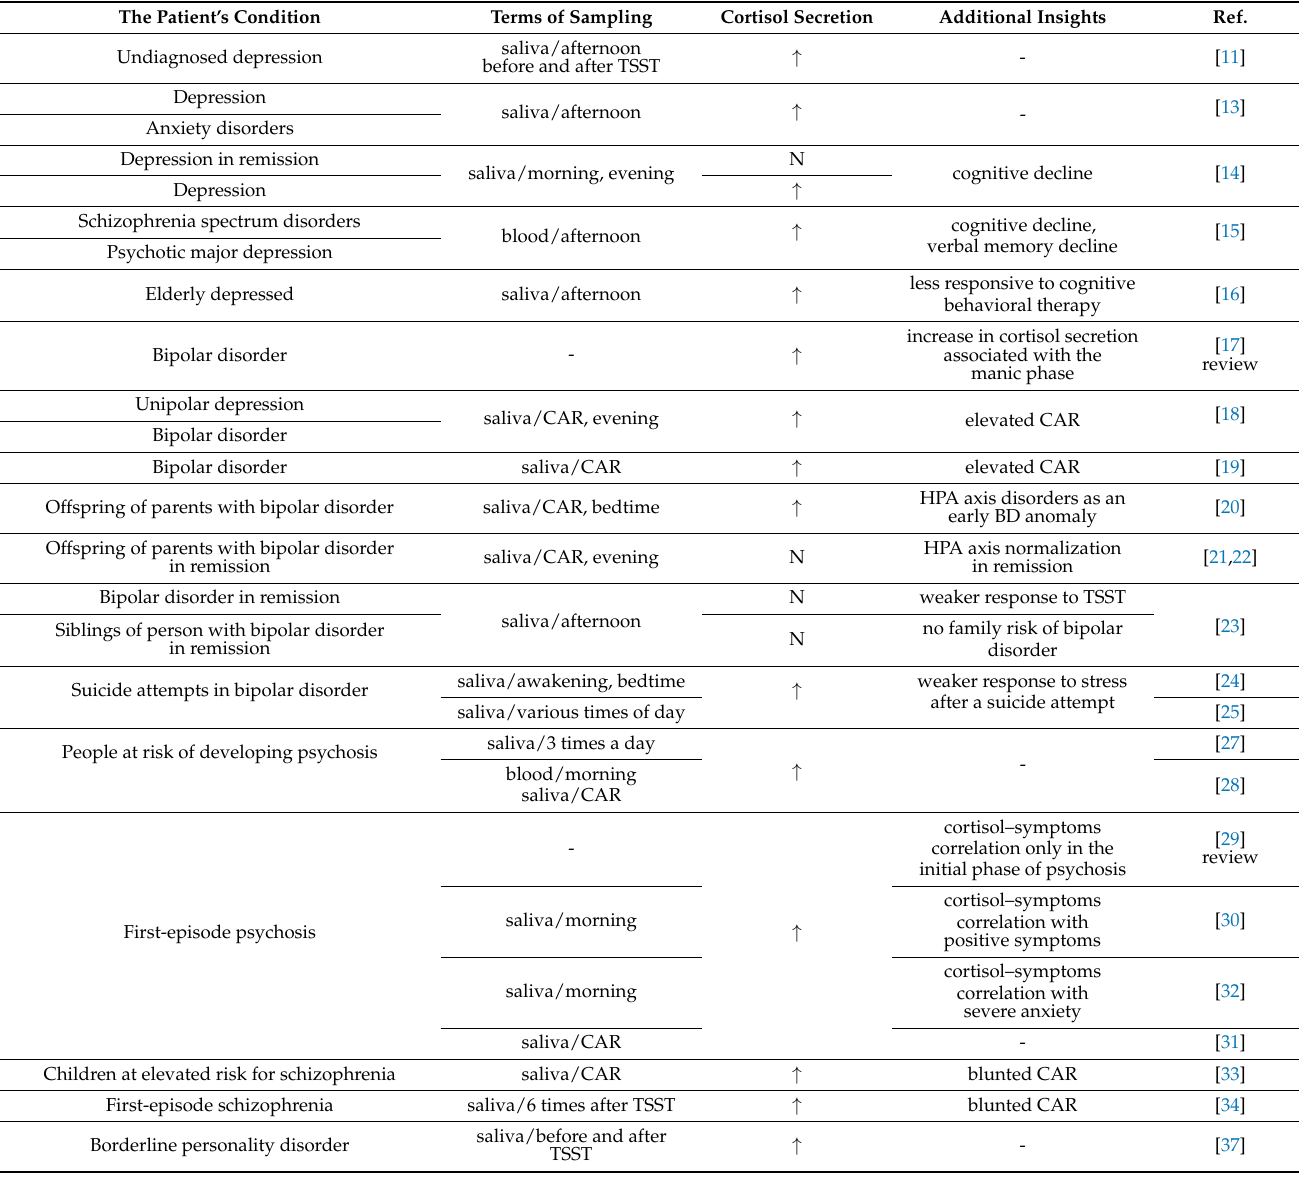
Table 1. Disorders of cortisol secretion in untreated